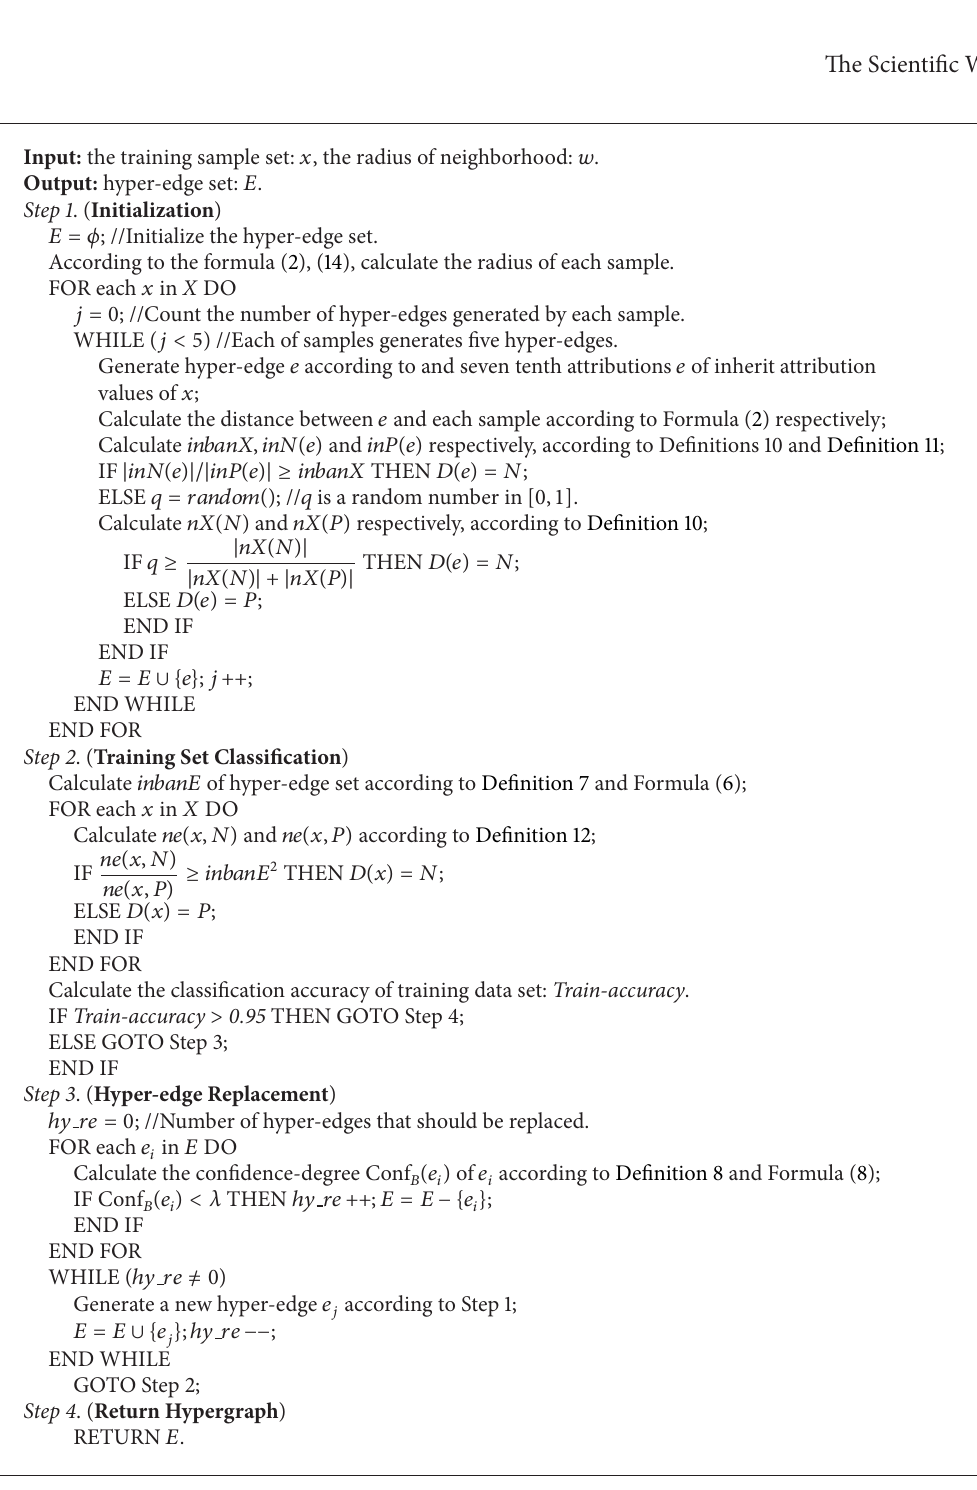
Algorithm 1: Neighbor hypergraph